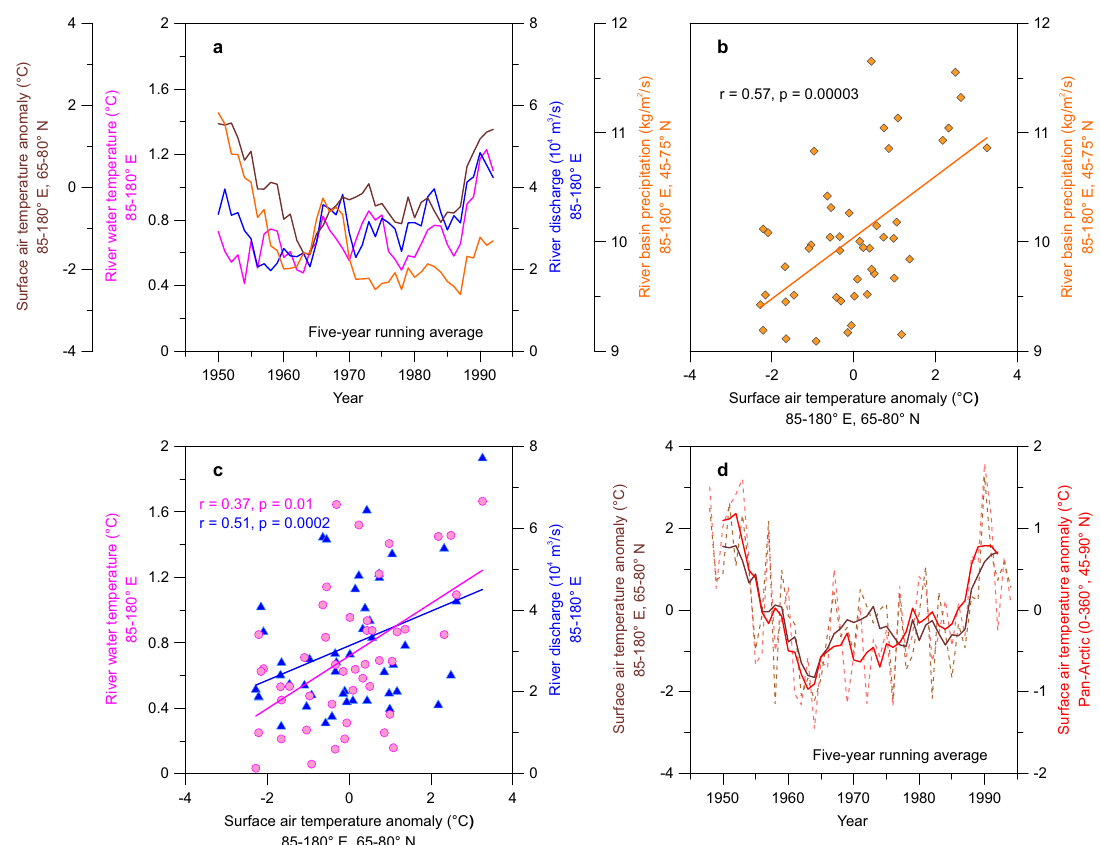
Fig. 3 | Instrumental records of modern pan-Arctic river water discharge and temperature. a Five-year running averages of the surface air temperature, river freshwater temperature, river runoff, and river basin precipitation in May from 1948 to 1994. b Surface air temperature in the East Siberian Arctic Shelf (ESAS) region versus river basin precipitation in May from 1948 to 1994. c Surface air temperature versus river freshwater temperature and surface air temperature versus river runoff. d Five-year running averages (solid lines) of the surface air